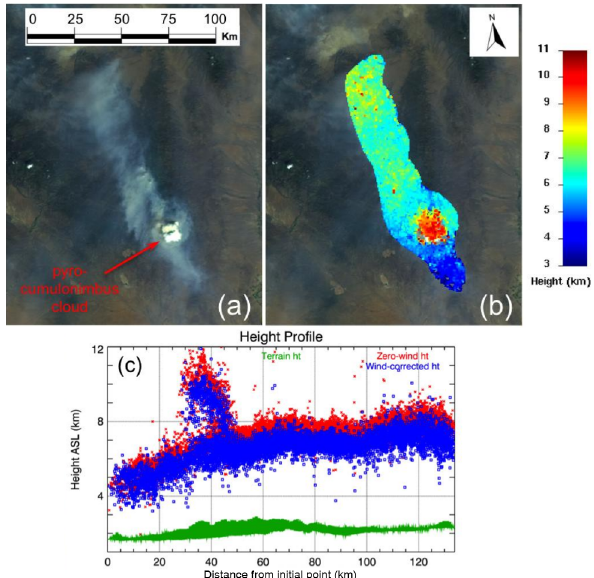
Figure 4. Example of smoke plume height derivation using data from the Multiangle Imaging SpectroRadiometer (MISR) that op- erates on the Terra satellite. This example is extracted from Nel- son et al. (2013). The fire took place on the 12 July 2013 in New Mexico and was observed by MISR at 18:09UTC. The MISR nadir RGB image showing a smoke plume in grey and a PyroCb in bright white is reported in (a) , when the plume stereo-heights derived from the MINX software (Nelson et al., 2013) are shown in (b) . MINX height retrieval profiles are shown in (c) . Note the dramatic differ- ence in the heights which reach 11–12kma.s.l. in the PyroCb and stay trapped in a layer around 6–8kma.s.l. in the